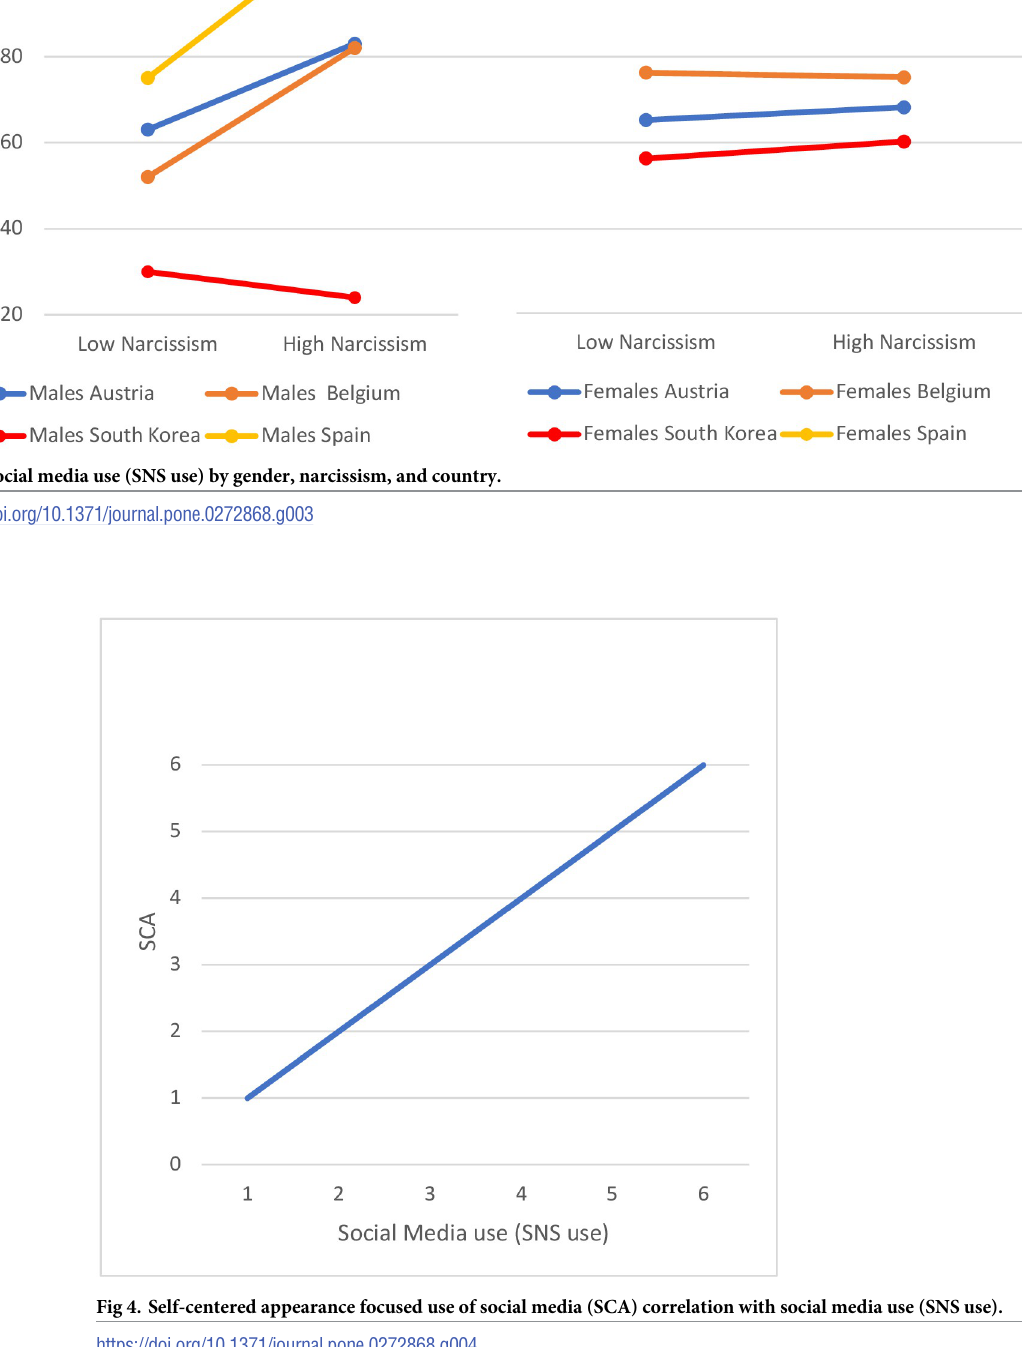
PLOS ONE | https://doi.org/10.1371/journal.pone.0272868 August 31,